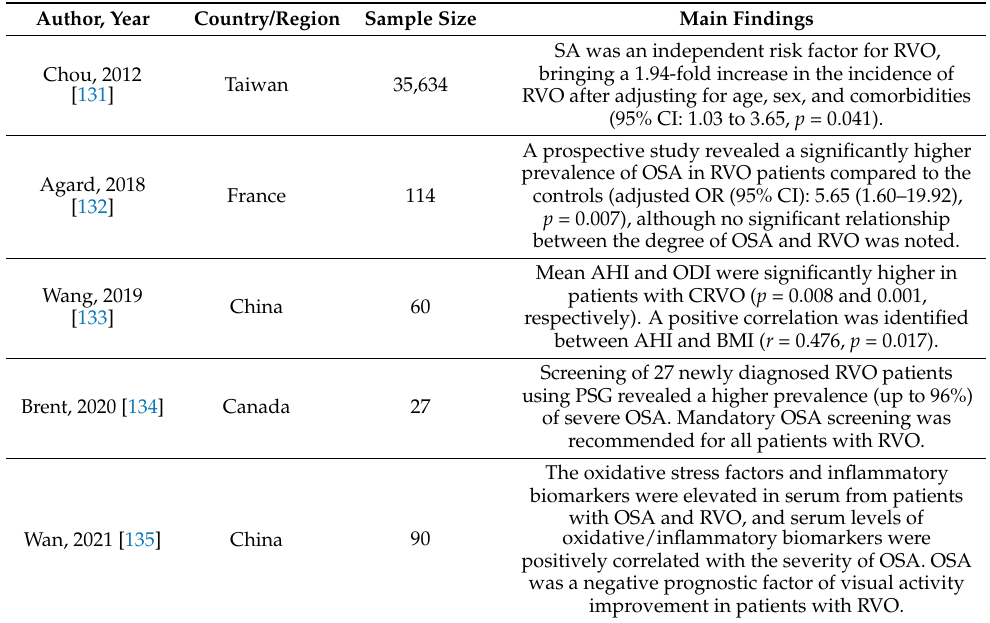
Table A4. Summary of the major studies evaluating the association between OSA and RVO.